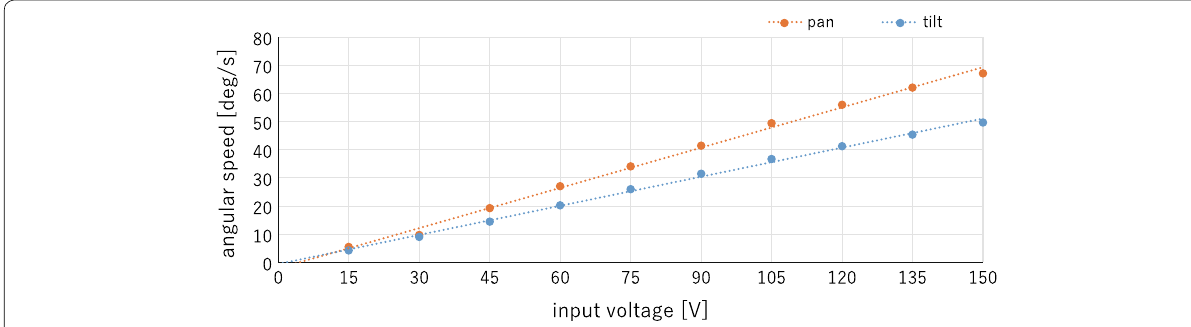
Fig. 8 Estimated inclinations of angular displacements and input voltages